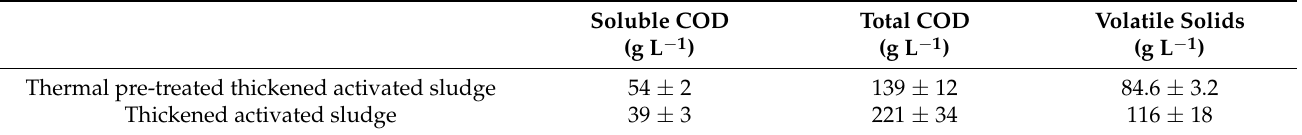
Table 1. Characterization of the substrates used with its respective standard